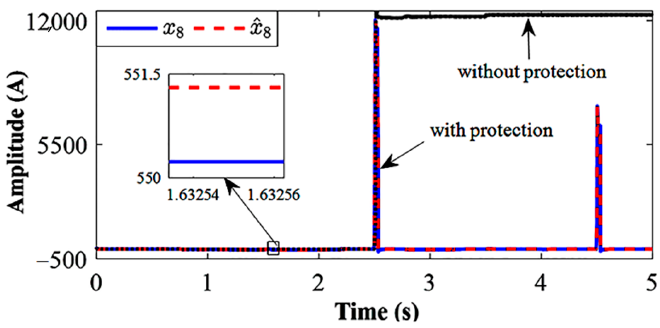
Figure 13. Capacitor voltage during fault occurrence in capacitor C 7 .